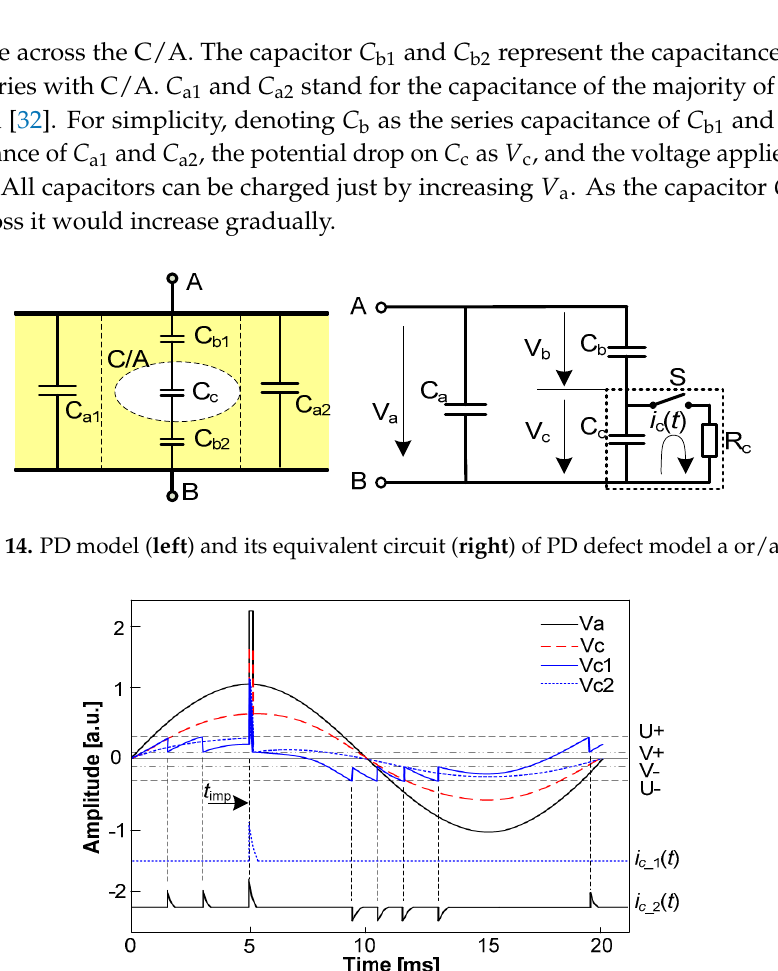
Figure 15. Repetition of PD pulses in a cavity or an air bubble under a combined waveform with square impulse superimposed on AC voltage.